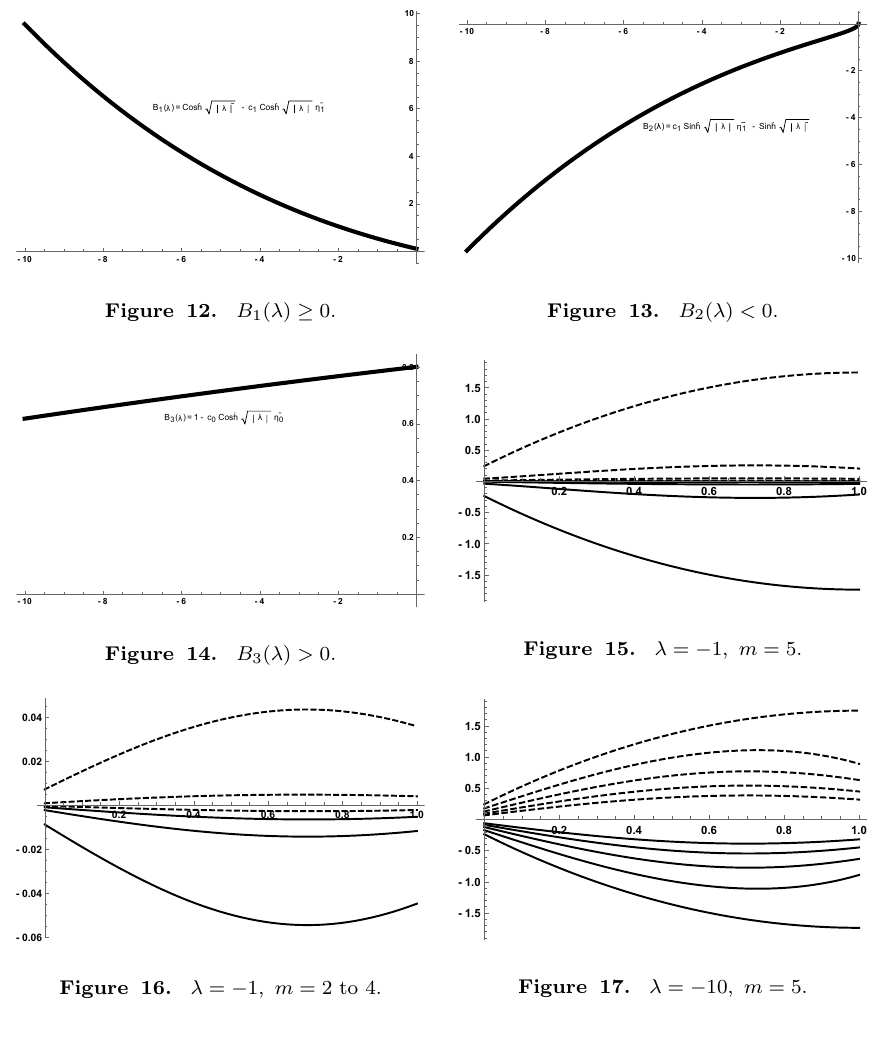
Figure 16. λ = − 1 , m = 2 to 4 . Figure 17. λ = − 10 , m = 5